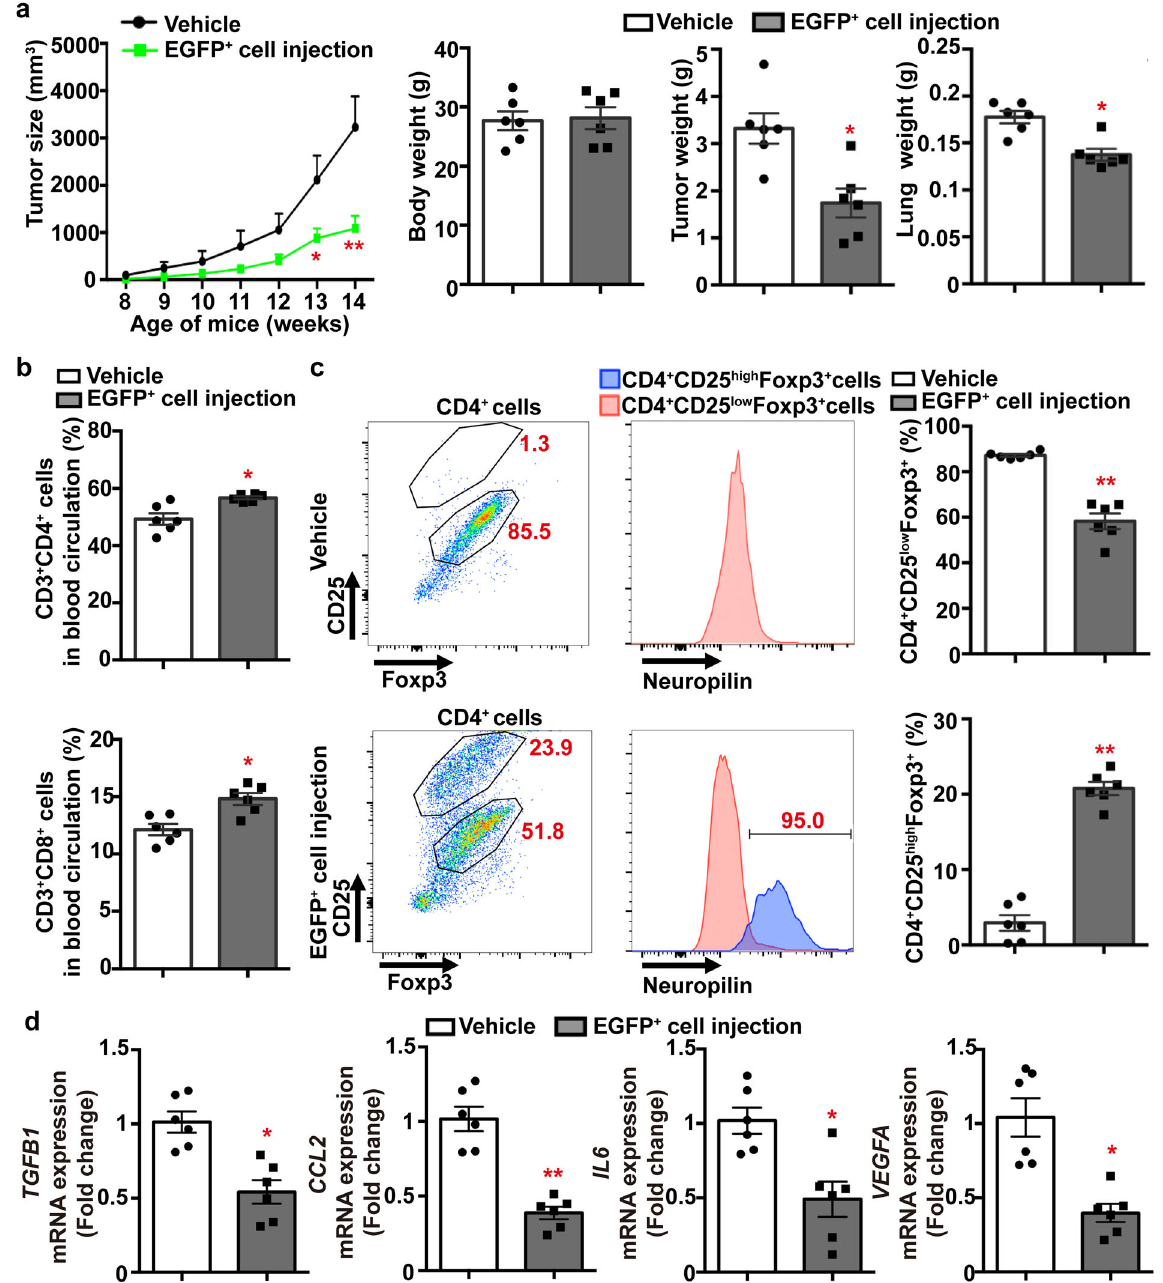
Fig. 7 Treatment with adiponectin-expressing thymocytes inhibits breast cancer development in MMTV-PyVT mice. Vehicle or EGFP + cells collected from the thymus of 4 – 5-week-old Adn-Cre/ROSA mt/mg mice were adoptively transferred into 4-week-old MMTV-PyVT mice via tail vein injection [30,000 cells/ mouse ]. Mammary tumor development was monitored once per week as described in the Methods. At the age of 14 weeks, mice were sacri fi ced to collect blood, tumor, and lung samples for analyses. a The tumor growth, body weights, tumor and lung tissue weights were measured and calculated for comparison. b Flow cytometry was performed to analyze the percentage composition of CD3 + CD4 + and CD3 + CD8 + T-cells in blood samples. c Flow cytometry was performed to analyze the Treg subpopulations in mammary tumors based on the antibody staining of CD4, CD25, Foxp3 and Nrp1. The percentage composition of CD4 + CD25 low Foxp3 + and CD4 + CD25 high Foxp3 + Treg were calculated for comparison. d The mRNA expression levels of genes including TGFB1 , CCL2 , IL6 and VEGFA were measured in tumor samples by QPCR. Data are presented as mean ± SEM. *, P < 0.05 and **, P < 0.01 vs corresponding vehicle controls ( n = 6 biologically independent samples from different animals of independent samples isolated from AKO, but not in the preparations of WT polyclonal antibodies recognizing different regions of CD100 mice (Fig. 9c, bottom left ). The extensive co-localization signals (Fig. 9c). The results demonstrated that adiponectin bound to between CD100 and galectin-3 were further con fi rmed by CD100 (Fig. 9c, top left ), consistent with the immuno fl uorescence immuno fl uorescence staining in TNC complexes of AKO mice co-staining results in TNC complexes isolated from WT mice (Fig. 9c, bottom right ). The phosphorylation levels of Lyn, a (Fig. 9c, top right ). By contrast, the protein-protein interactions predominant Src-family kinase regulating self-tolerance 34 , were between CD100 and galectin-3 were only detectable in TNC